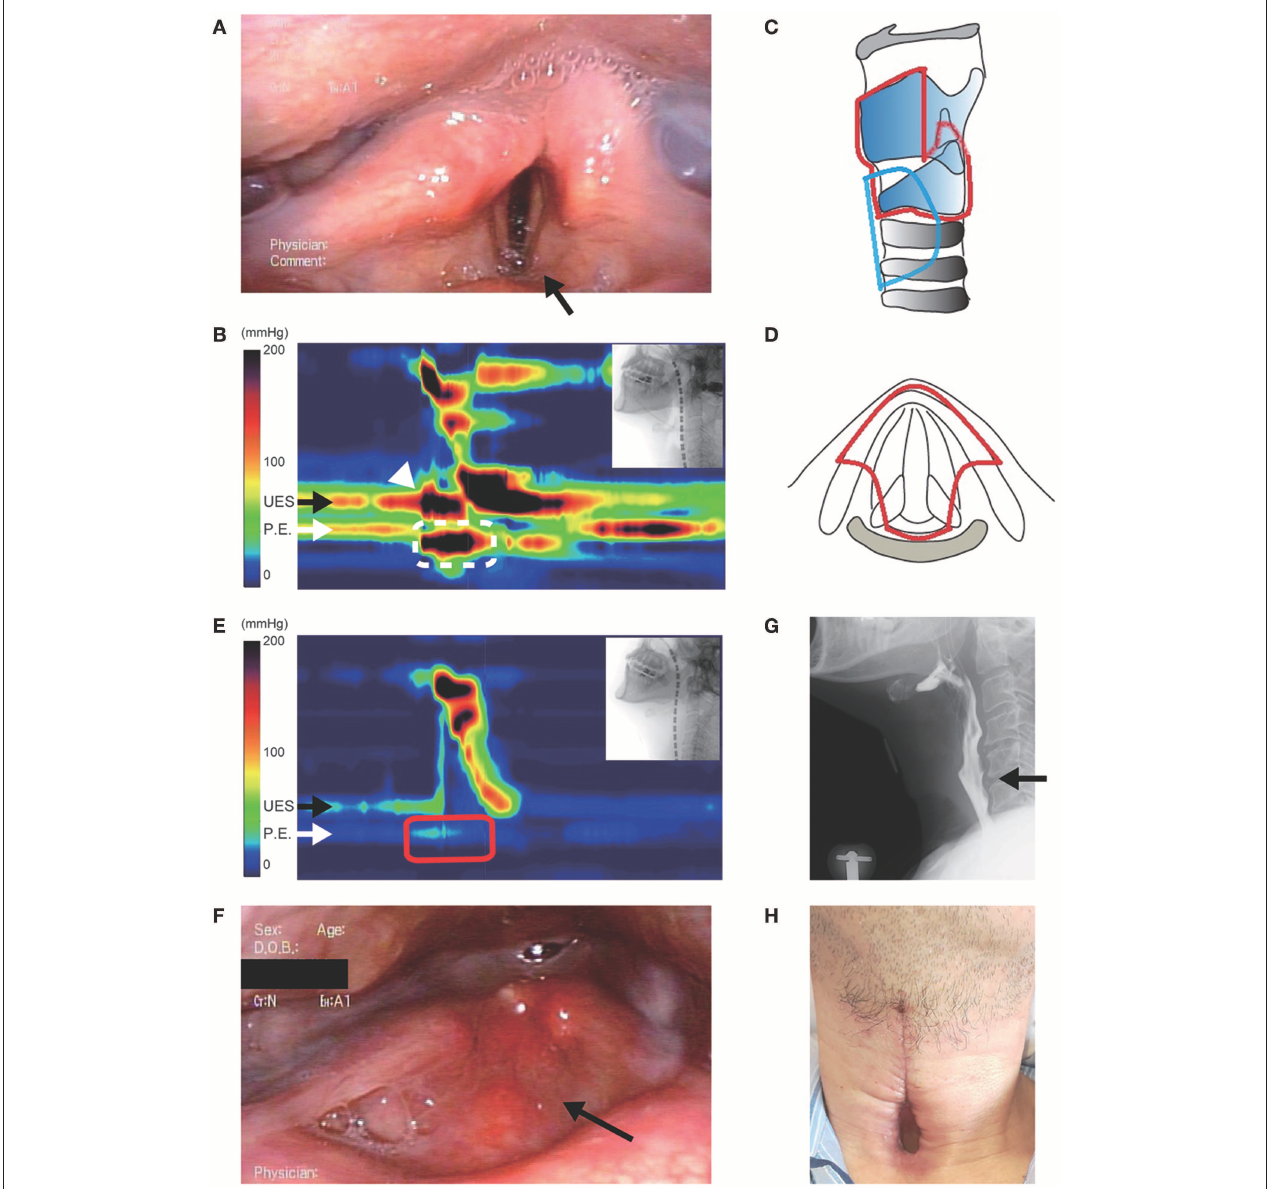
FIGURE 1 | Clinical findings in case 1. (A) Preoperative fiberoscopic view. Vocal cord abduction was insufficient bilaterally, and saliva was aspirated into the subglottic area (arrow). (B) Preoperative high-resolution manofluorography (HRMF) finding. The black arrow shows the level of the upper esophageal sphincter (UES). The white arrow shows the level of the proximal esophagus (PE). HRMF revealed UES opening impairment during swallowing (white arrowhead) and abnormal deglutitive proximal esophageal contraction (ADPEC, the area surrounded by a white broken line). (C,D) Schemas of the surgery. Lateral view (C) and axial view (D) . The removed area is encircled by a red line, and the location of the permanent tracheostoma is encircled by a blue line. (E) Postoperative HRMF finding. The resting UES pressure became low, and ADPEC disappeared postoperatively (the area surrounded by a red line). (F) Laryngeal fiberoscopic view after the surgery.